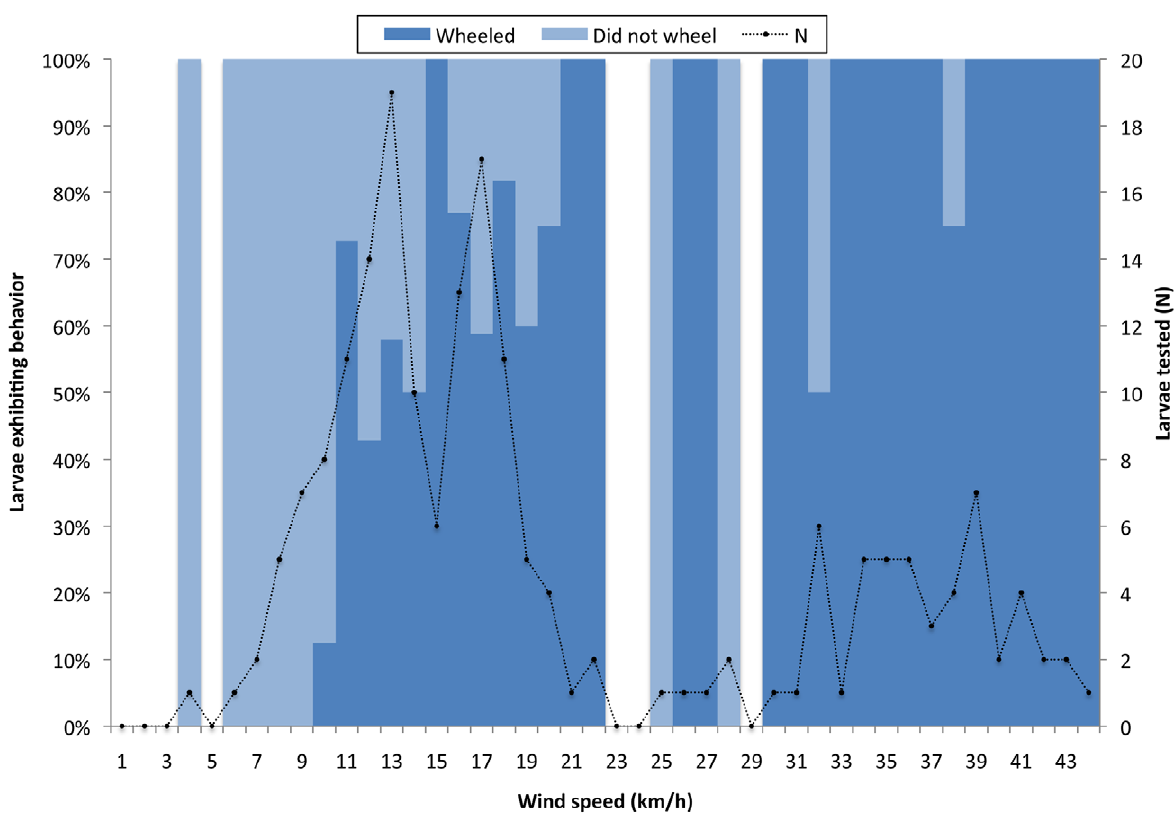
Figure 4. Effect of wind speed on probability that leaping C.dorsalismedia larvae would wheel. These trials were done on smooth beach surfaces, including all data from 2007 and from the ‘‘smooth’’ treatment in 2010.